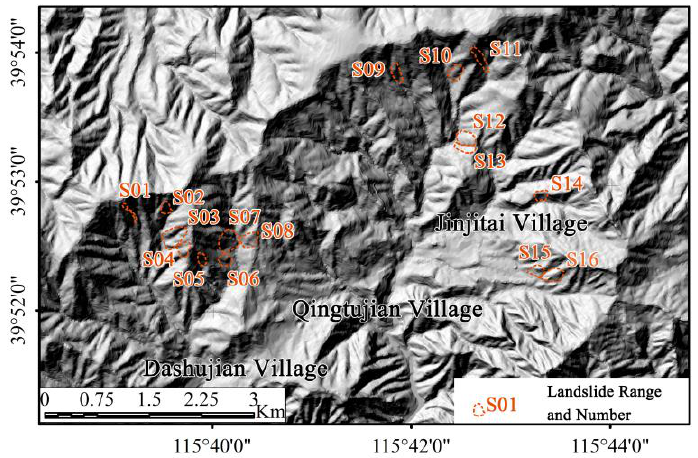
Figure 4. Medium-sized landslides in the Study Area. The base map is shaded relief map. Table 3. Basic information of landslides.